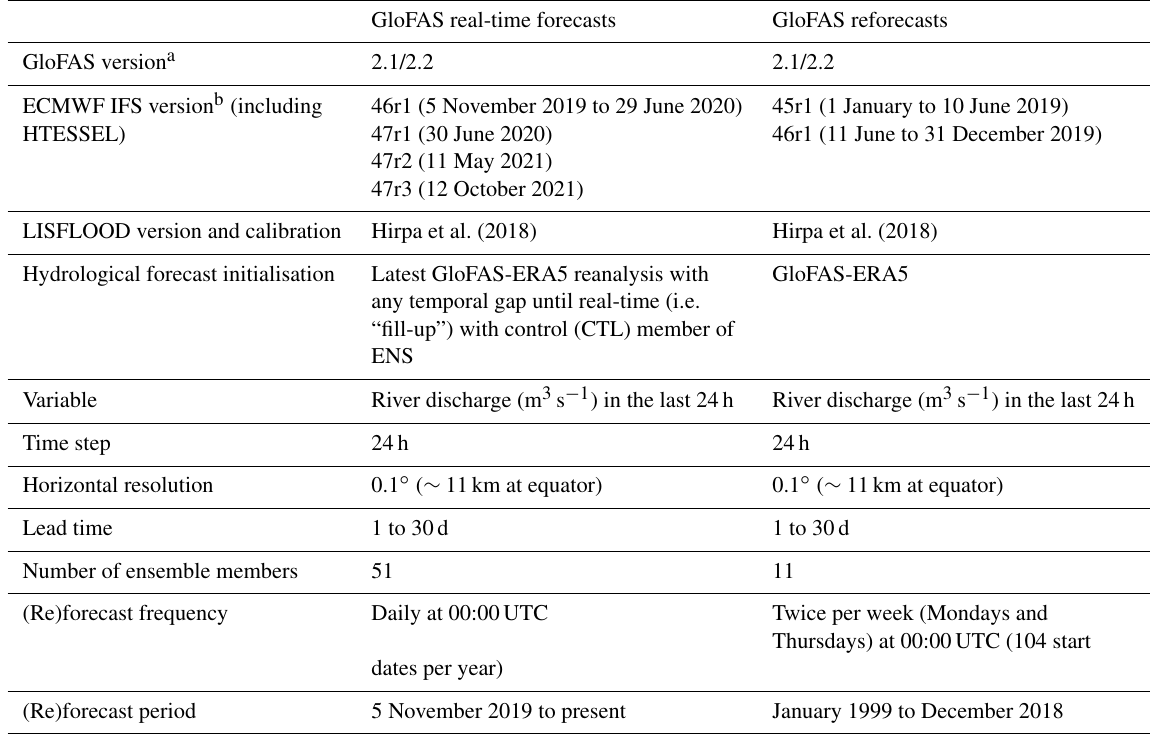
Table 1. Real-time forecast and reforecast configurations for GloFAS version 2.1/2.2.